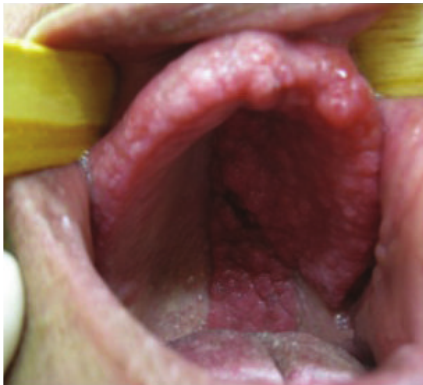
Figure 1: Verrucous lesions without facial midline involvement.